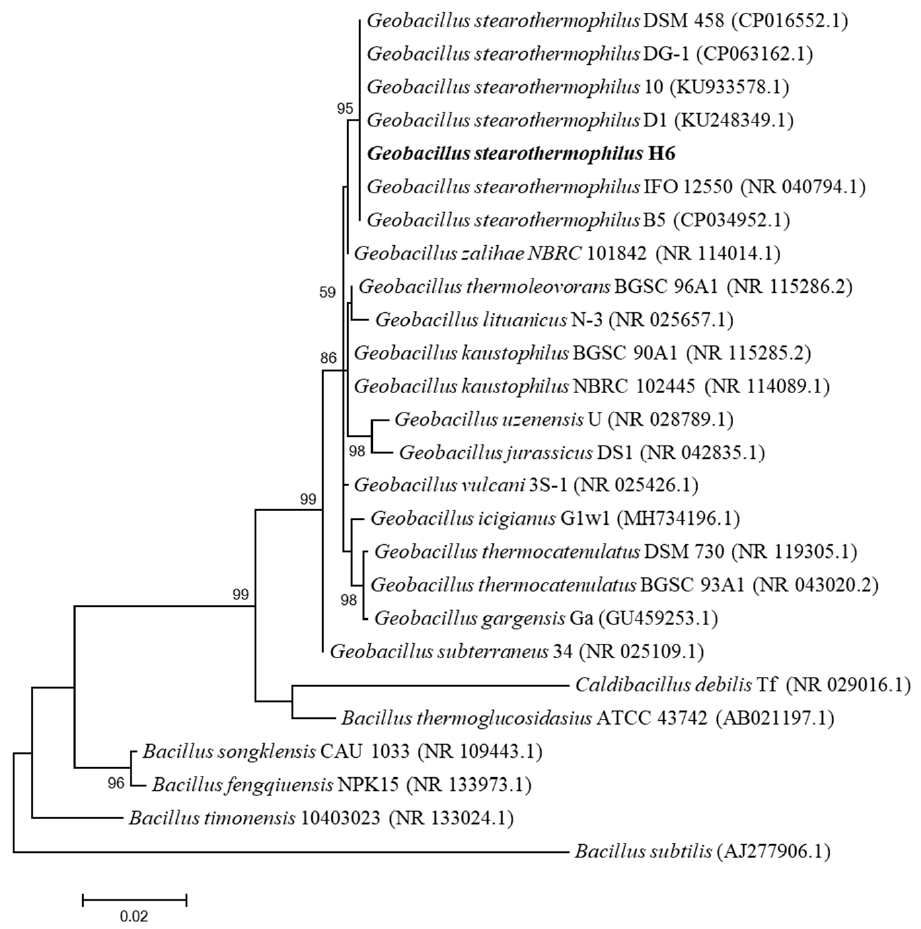
Figure 1. Phylogenetic tree of the 16S rRNA gene sequence based on maximum likelihood (ML). This tree shows the phylogenetic relationships between G. stearothermophilus H6 and closely related species. The GenBank registration number of the 16S rRNA gene sequence is shown in parentheses. Bootstrap test: the percentage is based on 1000 duplicates (bootstrap value > 70, indicating that the branch is reliable, and less than 50% will not be